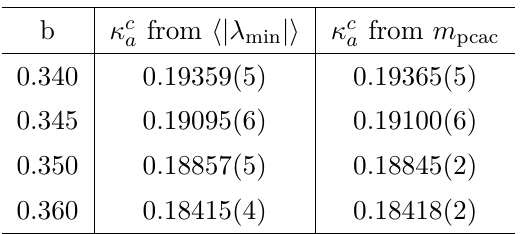
Table 1. Values of the adjoint critical hopping parameter κ c function of 1 / (2 κ a ) , of